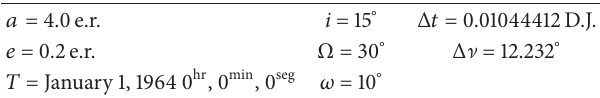
Table 1: Orbital elements and temporal distance between ⃗𝑟 1 and ⃗𝑟 2 . Reference Orbit I.